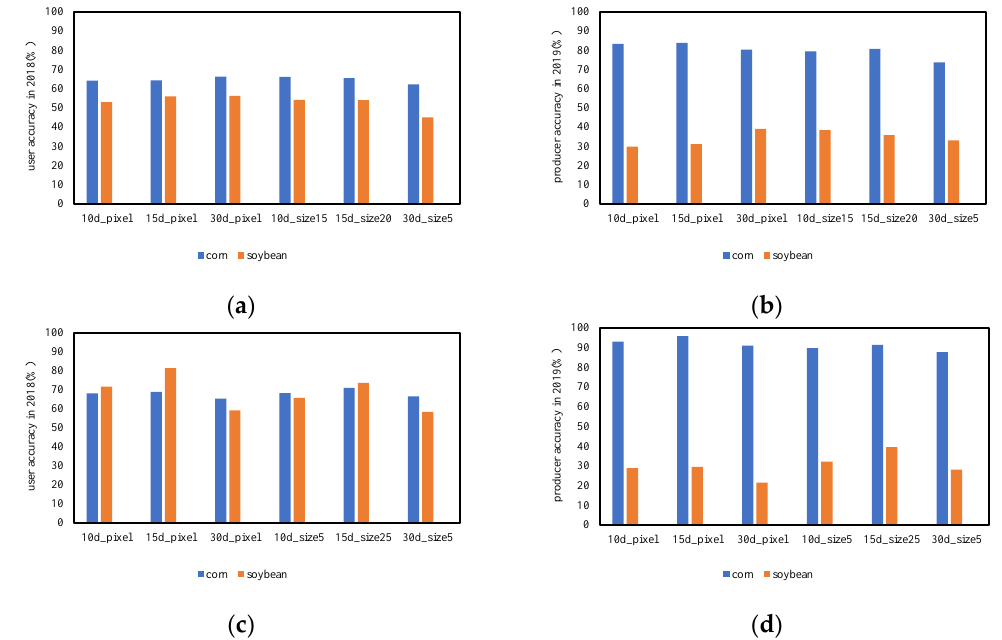
Figure 9. Producer accuracy and user accuracy of highest crop classification accuracy with different time intervals in Tongnan town at 2018 and 2019, there are only 2 rice sample sites in Tongnan Town, so no rice sample sites are assigned to the verification sample sites (( a ) user accuracy in 2018; ( b ) producer accuracy in 2018; ( c ) user accuracy in 2019; ( d ) producer accuracy in 2019).